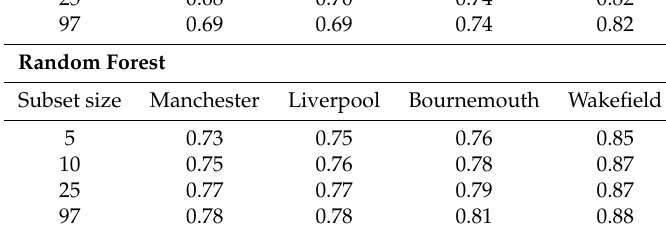
Random Forest Subset size